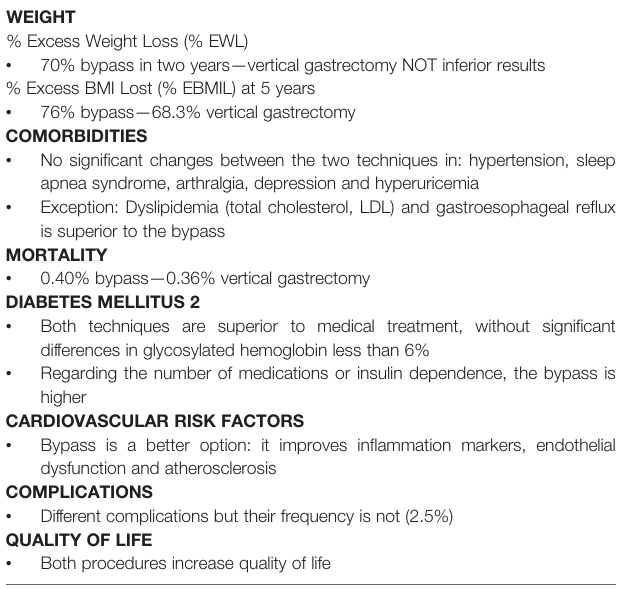
TABLE 1 | Obesity: Gastric bypass versus vertical gastrectomy. WEIGHT % Excess Weight Loss (% EWL)